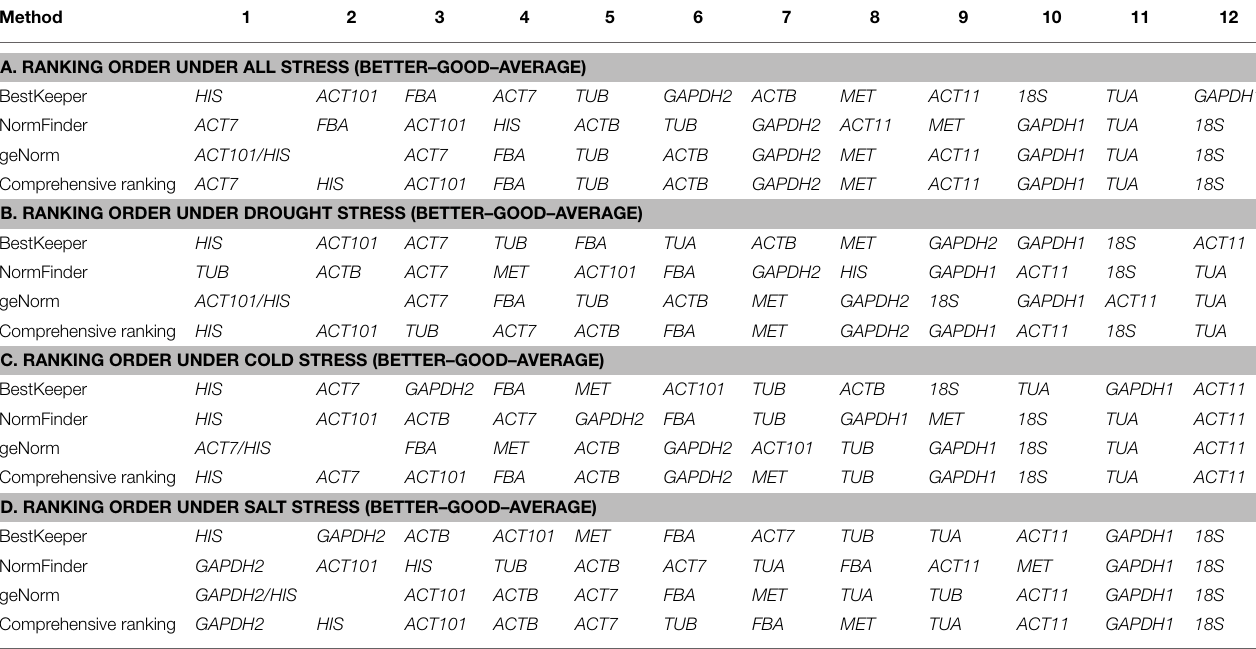
TABLE 5 | Expression stability ranking of the 12 candidate reference genes.